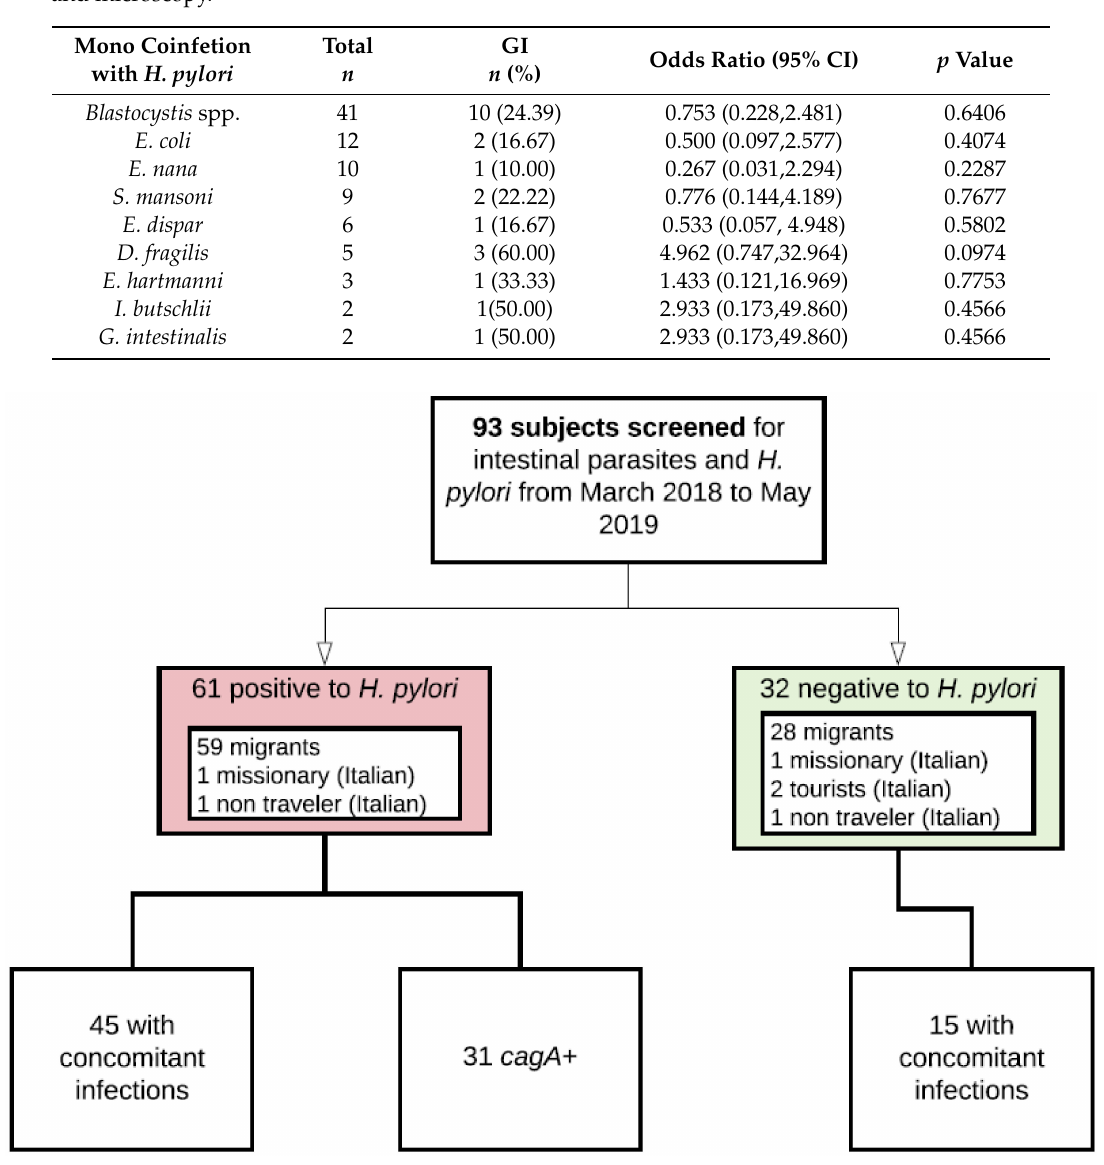
Table 5. Frequency of GI symptoms by type of infection in the subset of subjects positive to H. pylori. H. pylori infection was detected by SAT. Intestinal parasites were examined by real-time PCR and microscopy.